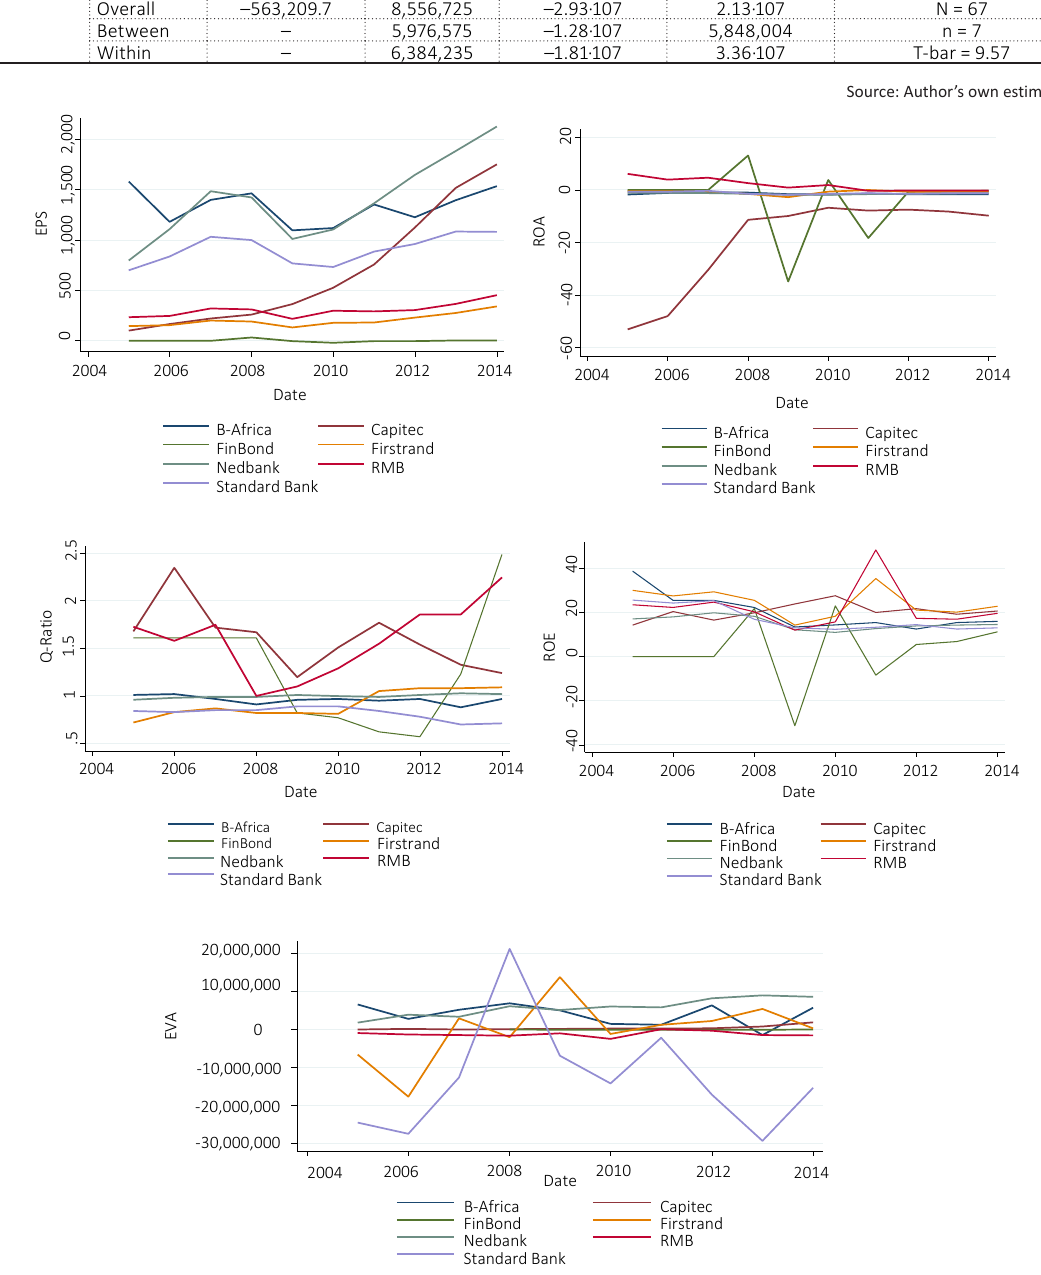
Figure 1. Line plots for financial performance of the banks over the period